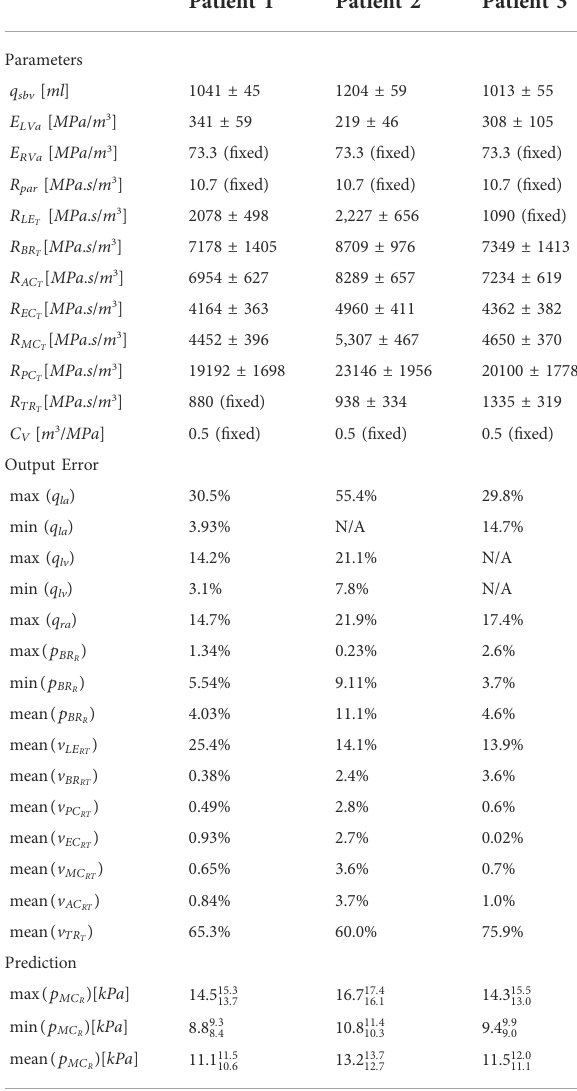
TABLE 3 Parameter estimates and standard deviations, error of the model output versus the measured data, and the core prediction values with con fi dence intervals. The ( fi xed) parameters were set to physiological values as they were not structurally identi fi able. N/A indicates measurements that were not obtained for that